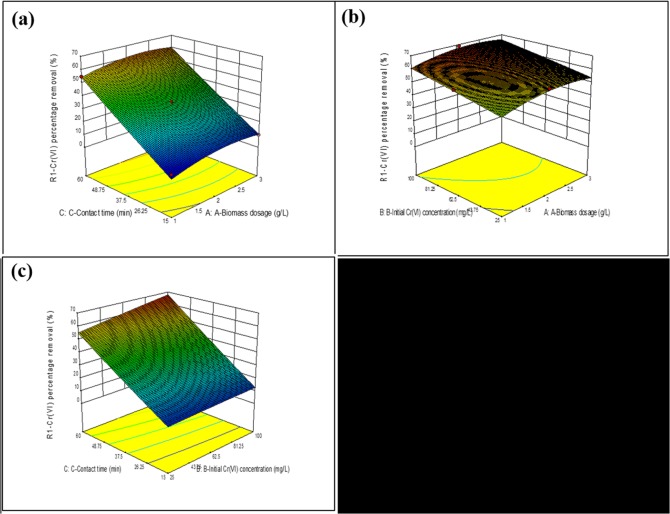
The 3D response surface plots showing the effects of interactions (a) biosorbent dosage on Cr(VI) removal; (b) initial Cr(VI) concentration on percent removal of Cr(VI); and (c) contact time on the percent of Cr(VI) removal.Note: A: biosorbent dosage (mg g−1); B: Cr(VI) concentration (mg L−1); C: contact time (min).